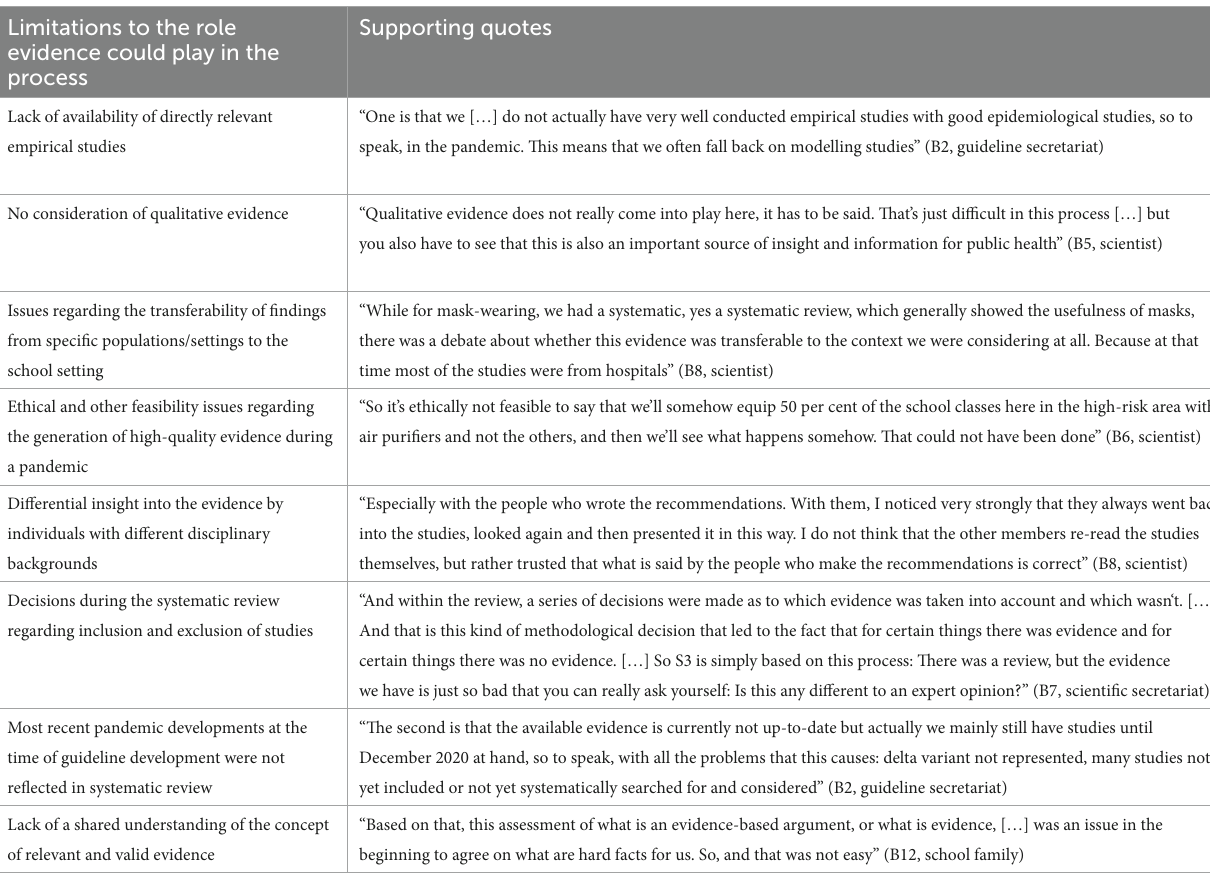
TABLE 4 Sub-category “Limitations to the role evidence could play in the process” with supporting quotes. Limitations to the role evidence could play in